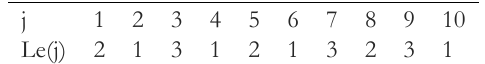
Table 3. The level of service for the patient demands.